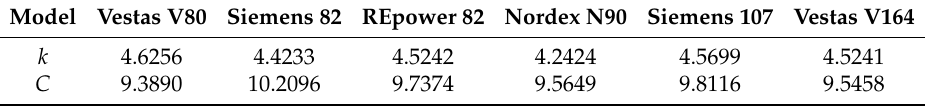
Table 2. Values of parameters ‘ k ’ and ‘ C ’ for several WTs using the proposed model.